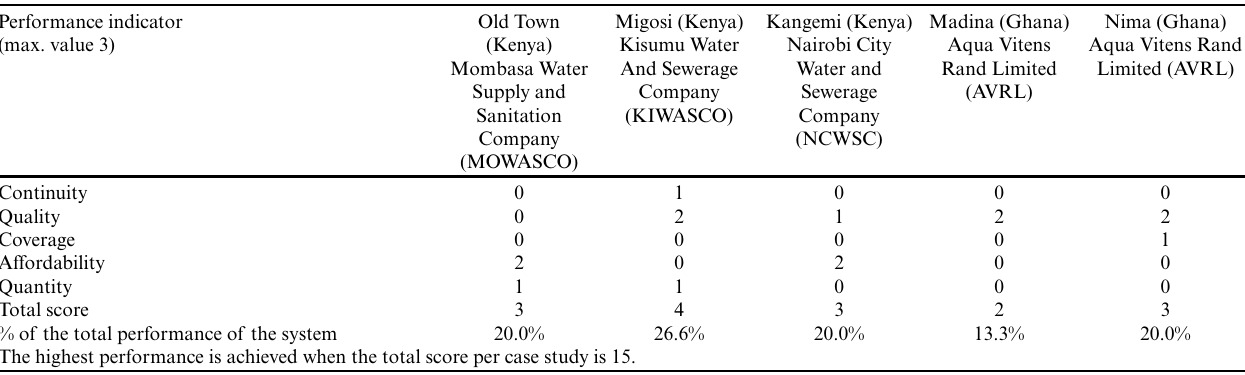
Table 5 . Performance score in Kenya case study locations following a water service delivery approach (WSDA). Performance indicator (max. value 3)